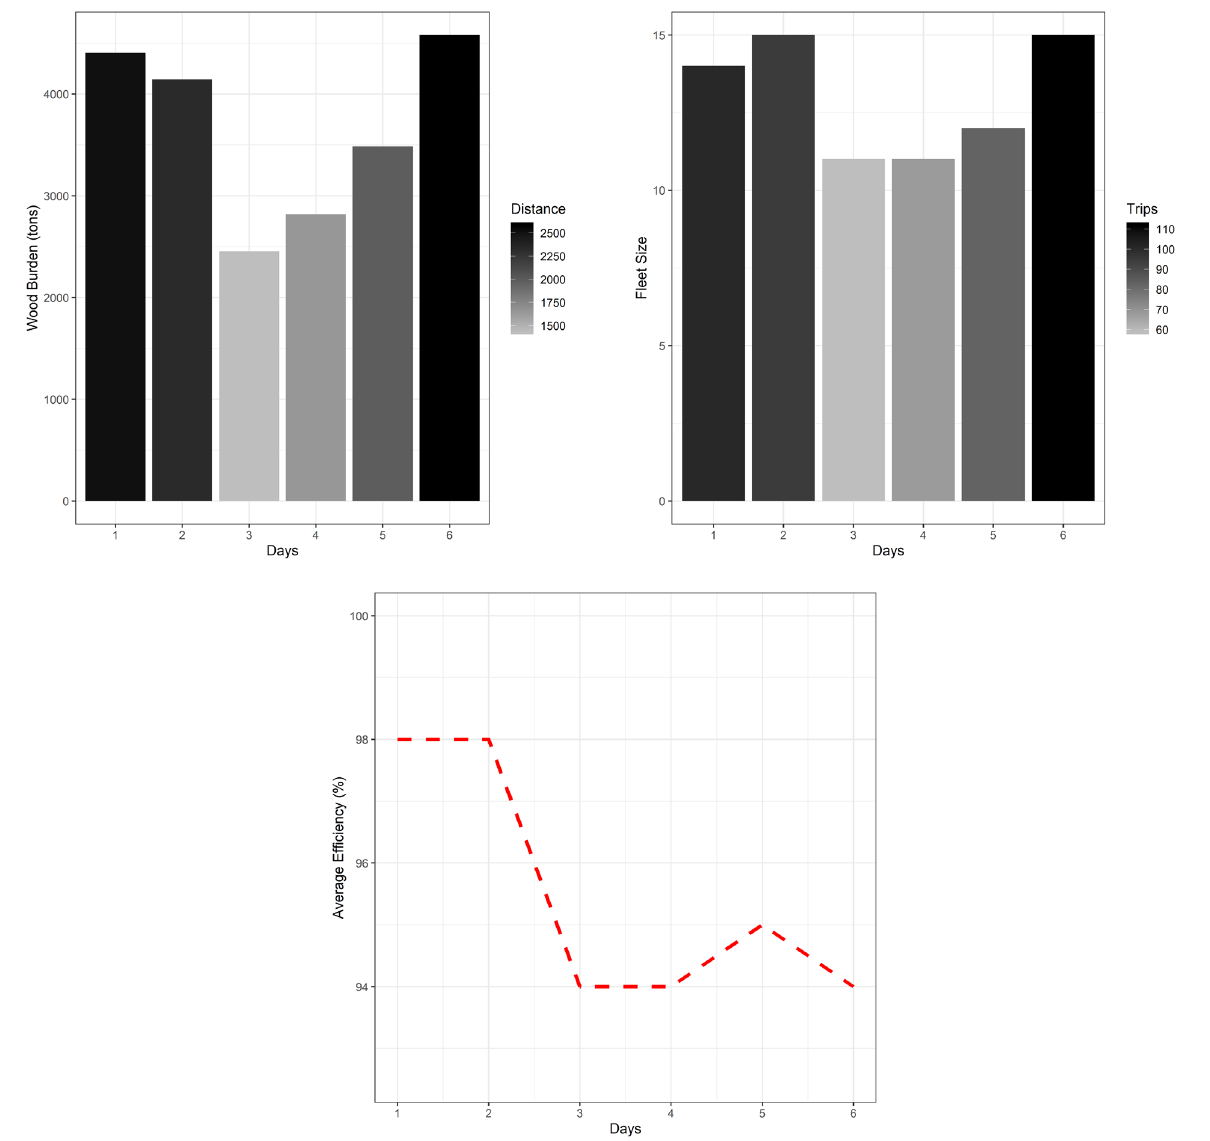
Figure 3. Mathematical model outcome information, where (a) travelled distance, kilometer, (dashed line) and load wood weight, tons, (area under the line); (b) fleet size (dashed line) and number of trips (area under the line); (c) Average efficiency e of transportation by the